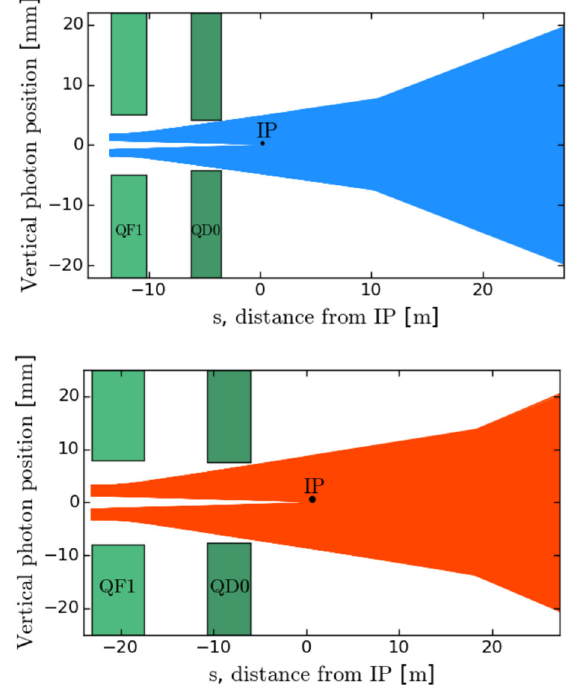
FIG. 16. Vertical position of the emitted photons through the FD and CLIC detector, up to the entrance of the first postcollision magnet, for L (cid:1) ¼ 3 . 5 m (top plot) and L (cid:1) ¼ 6 m (bottom